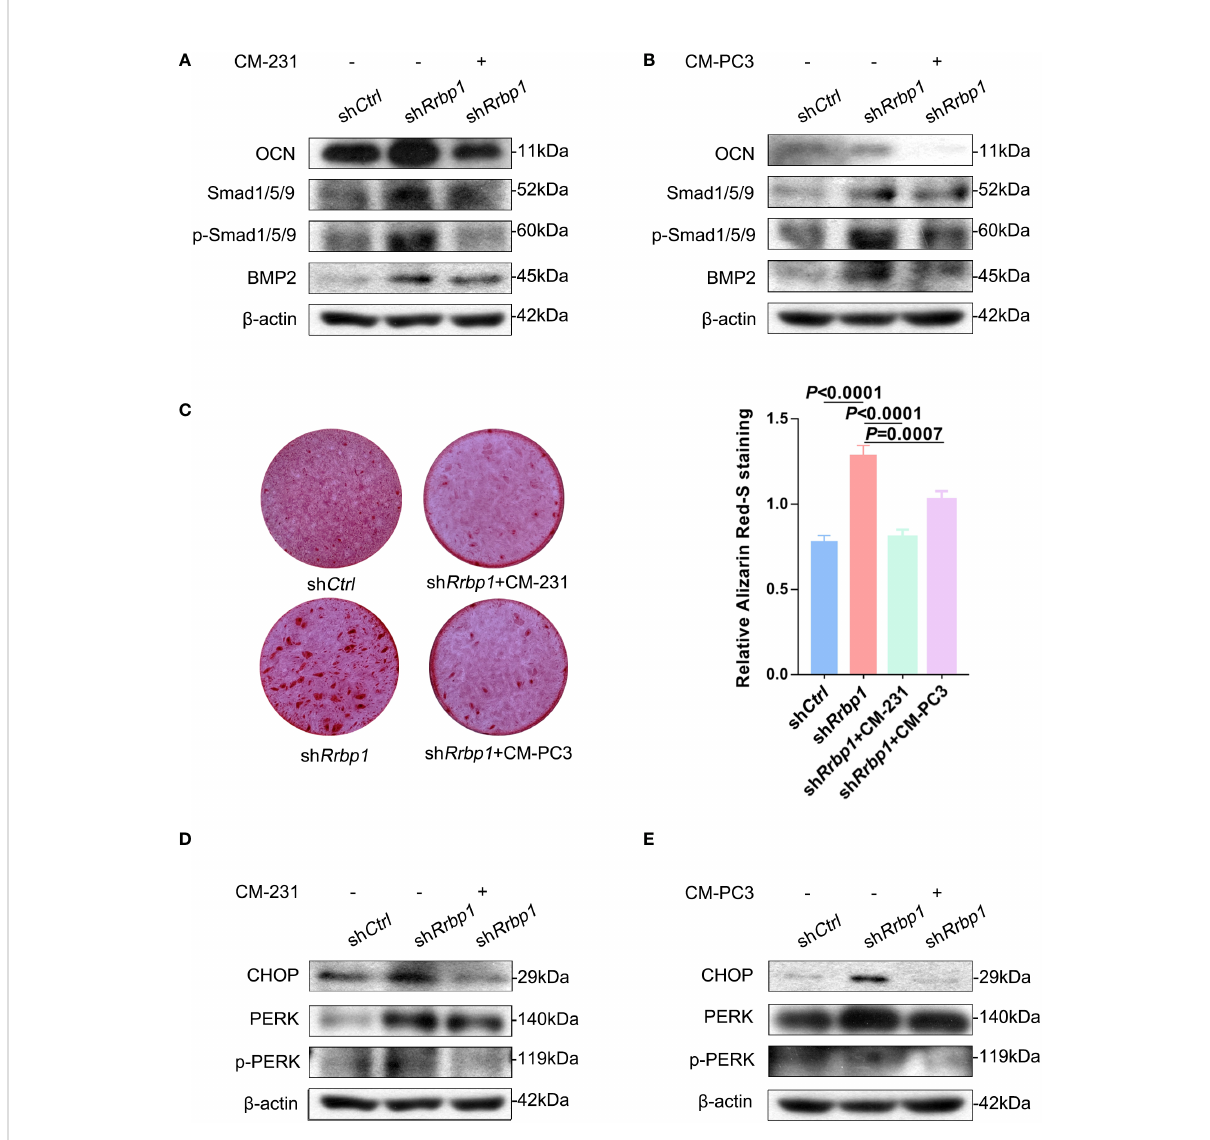
FIGURE 6 The effect of CM from MDA-MB-231 or PC3 cells on the osteoblastic phenotypic expression in MC3T3-E1 cells transduced with sh Rrbp1 . (A, B) MC3T3-E1 cells transduced with sh Rrbp1 were cultured in a -MEM+CM-231 or a -MEM+CM-PC3 for 7d, respectively. The protein levels of OCN, BMP2, Smad1/5/9, p-Smad1/5/9, and b -actin were measured via western blotting analysis. (C) MC3T3-E1 cells transduced with sh Rrbp1 were cultured in a -MEM+ CM-PC3 and a -MEM+CM-PC3 for 28 d, respectively, followed by ARS staining. Left panel: representative images; right panel: absorbance values at 575 nm of different groups. (D, E) MC3T3-E1 cells transduced with sh Rrbp1 were cultured in a -MEM+CM-231 or a -MEM+CM-PC3 for 7d. The protein levels of CHOP, IRE a , p-IRE a , PERK, p-PERK, and b -actin were measured via western blotting analysis. The data are representative of three independent